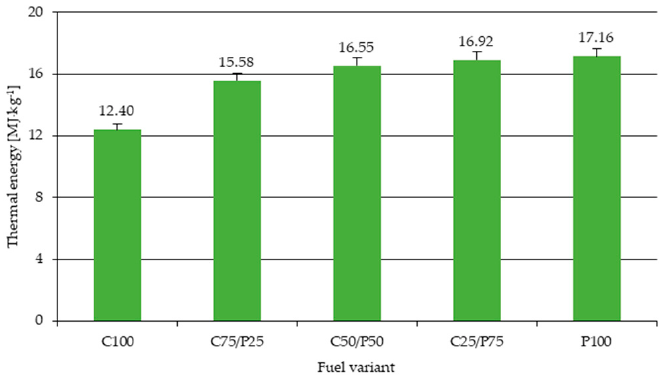
Figure 6. Average heat yield per kilogram of fuel.